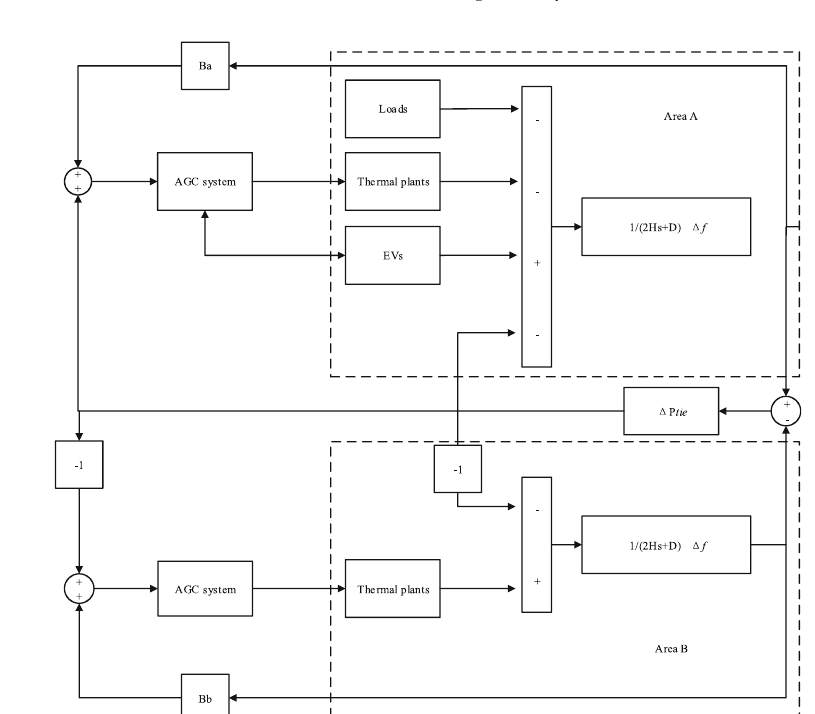
Fig. 7 A two-area interconnected power system